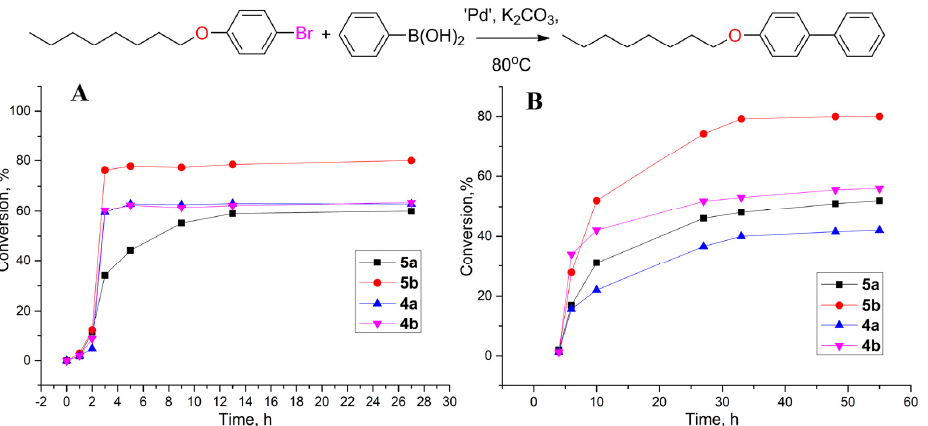
Figure 4. Conversion of p -octyloxybrombenzene vs. time in Suzuki–Miyaura reaction between p -octyloxybrombenzene and phenylboronic acid in DMF ( A ) or DMF:water 1:3 mixture ( B ). n( p - C 8 H 17 OC 6 H 4 Br) = 0.16 mmol, n(PhB(OH) 2 ) = 0.28 mmol, n(K 2 CO 3 ) = 0.28 mmol, n( 4a , b and 5a , b ) = 0.16 μ mol, 80 ° С , and V = 0.8 mL.